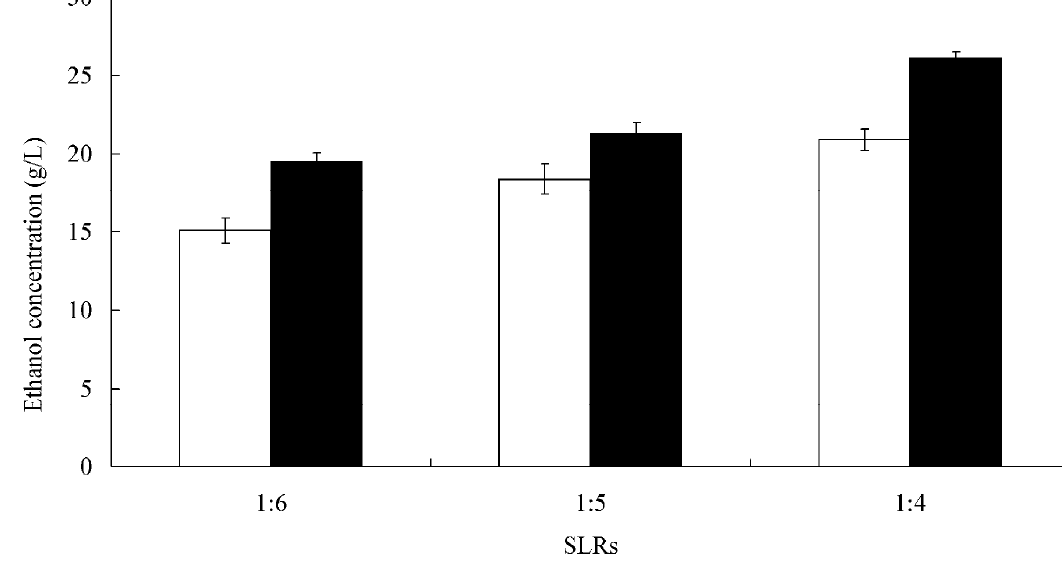
Figure 2. Ethanol production from L. punctata mash pretreated by pectinase at different solid-liquid ratios (SLRs). ( □ ): Ethanol production from untreated mash; ( ■ ): Ethanol production from pectinase pretreated mash (7 PECTU/g mash). Error bars represent standard